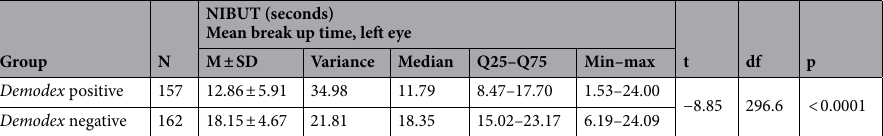
NIBUT (seconds) Mean break up time, left eye